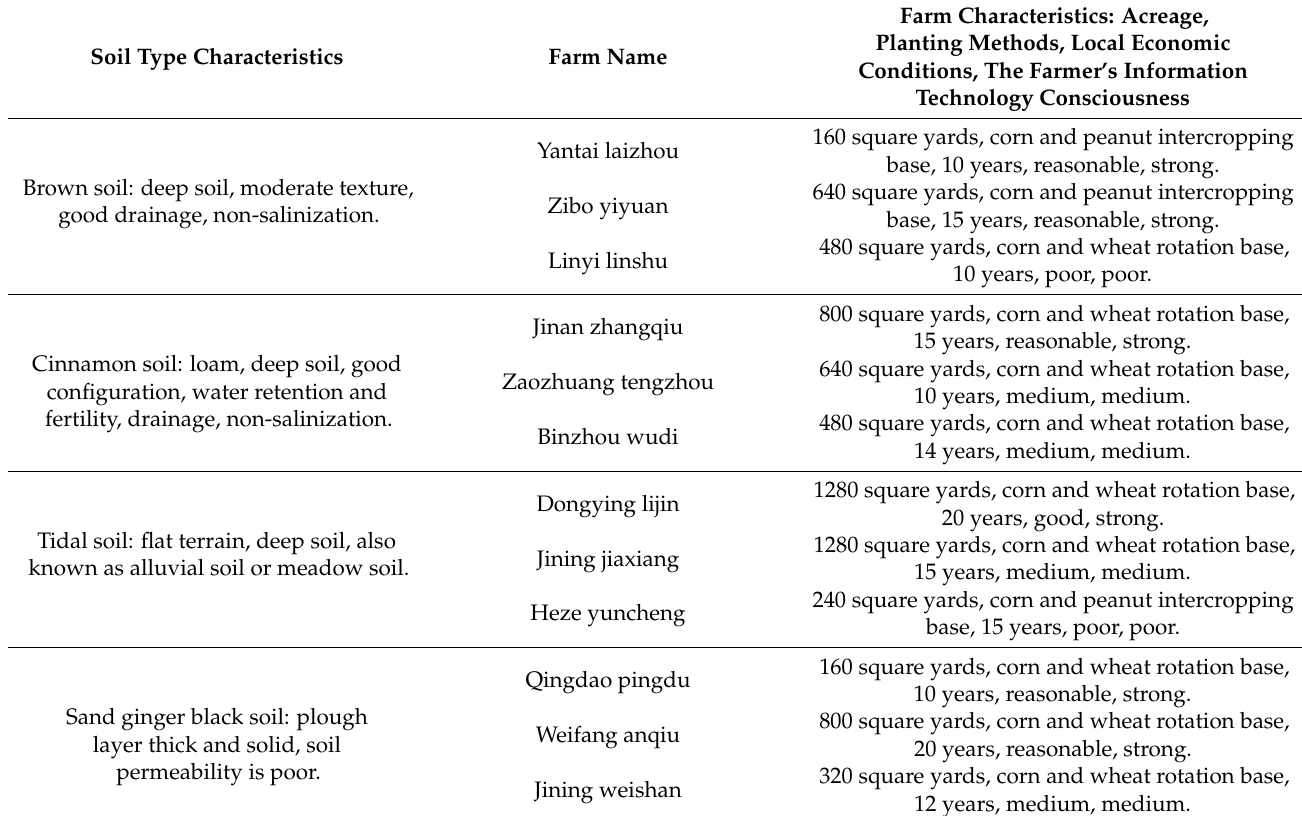
Table 3. Farm and cropping